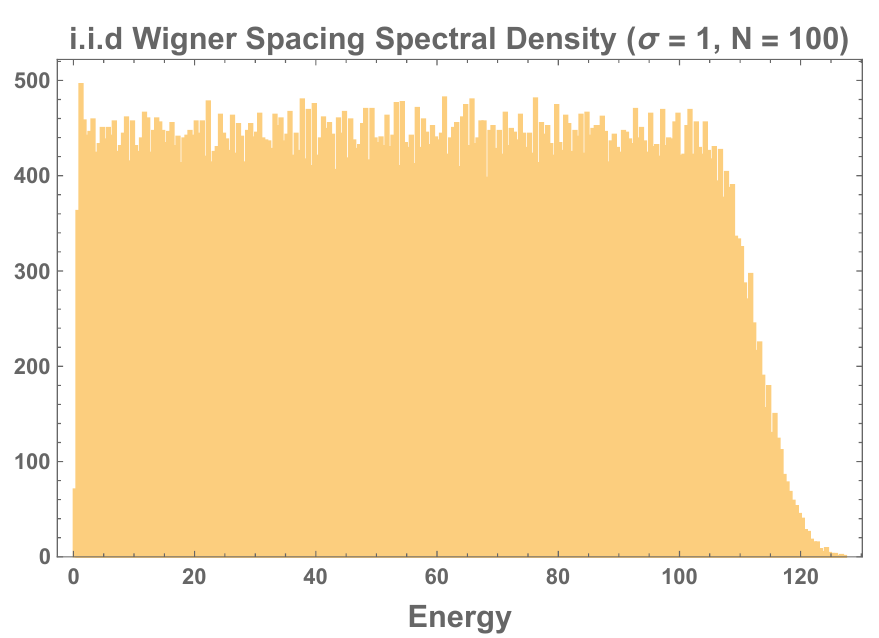
Figure 8 . Above is a histogram of eigenvalues generated by the i.i.d model for 100 eigenvalues (excluding the ground state at E = 0 ) defined in eq. (2.1). The NNS distribution is given by eq. (3.13) with σ = 1 . We expect the width of the spectral density to scale with N